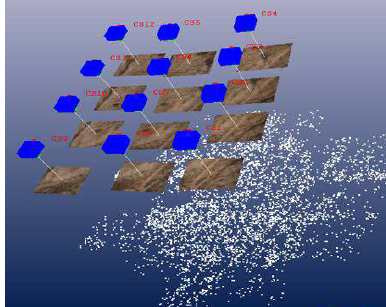
Figure 3. Mosaic of the photos and the automatic points obtained in the relative orientation